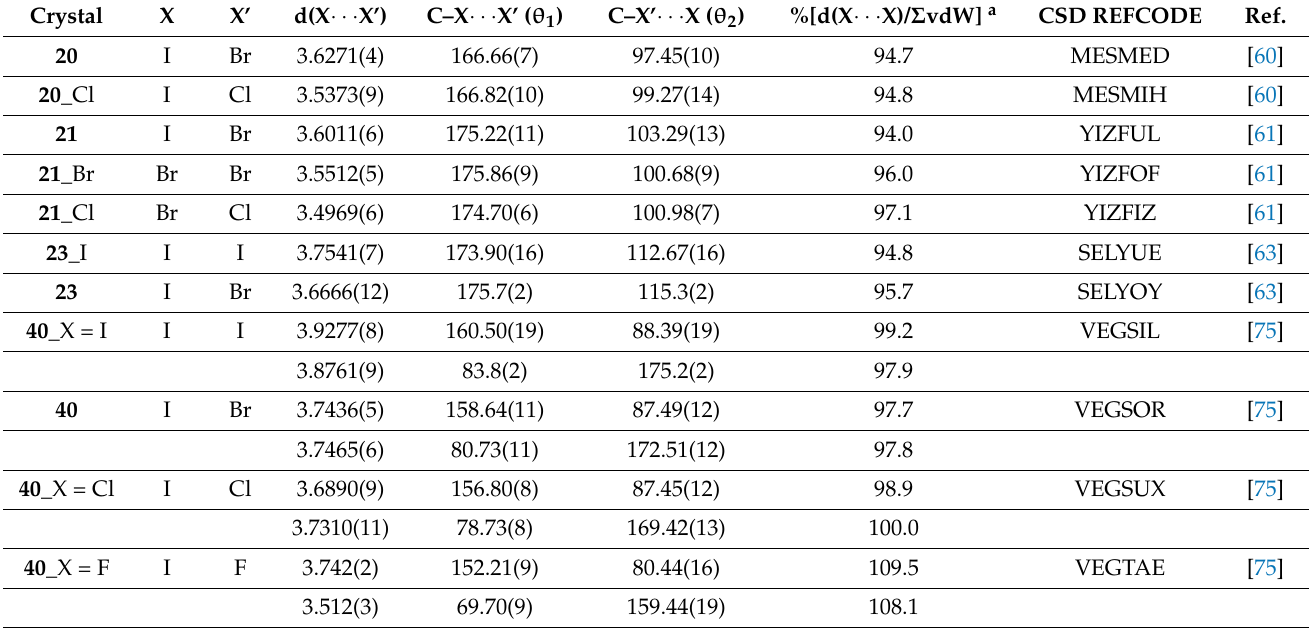
Table 2. Summary of geometric parameters (Å, ◦ ) in congeners of 20 , 21 , 23 and 40